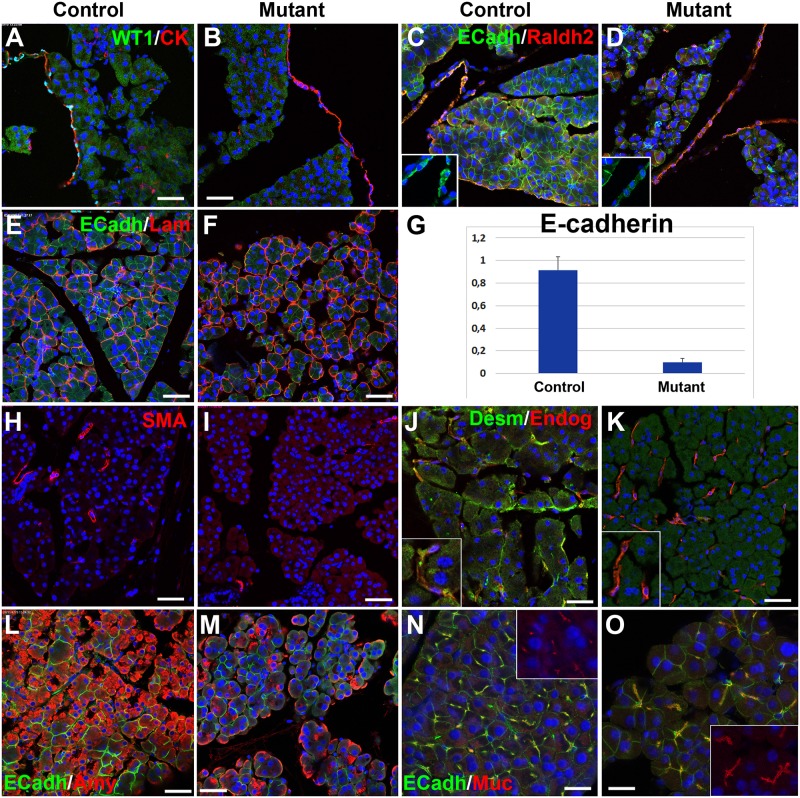
Pancreatic phenotype after systemic deletion of WT1 in the Wt1CreERT2;Wt1flox model.A,B. WT1 is expressed only in the pan-cytokeratin+ mesothelial cells of control mice (A) and is deleted in the mutant mice (B). C,D. E-cadherin expression is downregulated in the pancreas of the mice with deletion of WT1, both in acini and mesothelium (inserts). However, mesothelial expression of RALDH2 does not change in mutant mice. E,F. Laminin expression is maintained in the mutant mice, but it reveals changes in the size, shape and adhesion of the acini. Note the E-cadherin immunoreactivity decrease in the mutant. G. E-cadherin downregulation in mutant mice is confirmed by qPCR (mean of three biological replicates, p<0.01, Student’s t test). H,I. Pancreatic stellate cells are not activated by the ablation of WT1, as demonstrated by the lack of SMC α-actin expression. J,K. Desmin+ pancreatic stellate cells become very scarce in the mutant mice. However, endoglin (CD105) expression is maintained in putative PSC. L,M. Amylase immunoreactivity is significantly reduced in mutant mice (quantified in Table 1). N,O. Upregulation and changes in the localization of mucin-1 immunoreactivity in mutant mice suggests loss of acinar cell polarity. Scale bars: 50 μm.